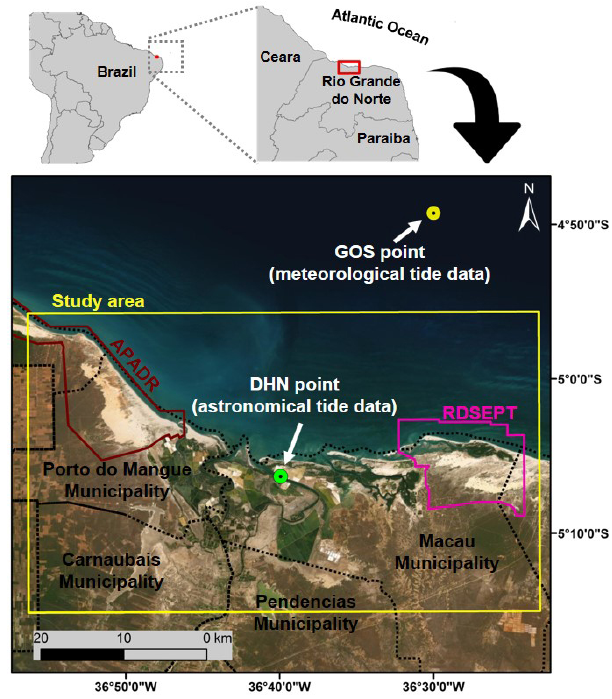
Figure 1. Location of the study area. The yellow rectangle repre- sents the delimitation of the study area: Piancó–Piranhas–Açu es- tuary and its surroundings. The pink polygon highlights the bound- ary of the Ponta do Tubarao State Sustainable Development Reserve (RDSEPT), while the burgundy polygon delimits the Rosado Dunes Environmental Preservation Area (APADR). The dotted black line represents the geopolitical boundaries of the municipalities that make up the study area. Basemap from ArcGIS Online: ©